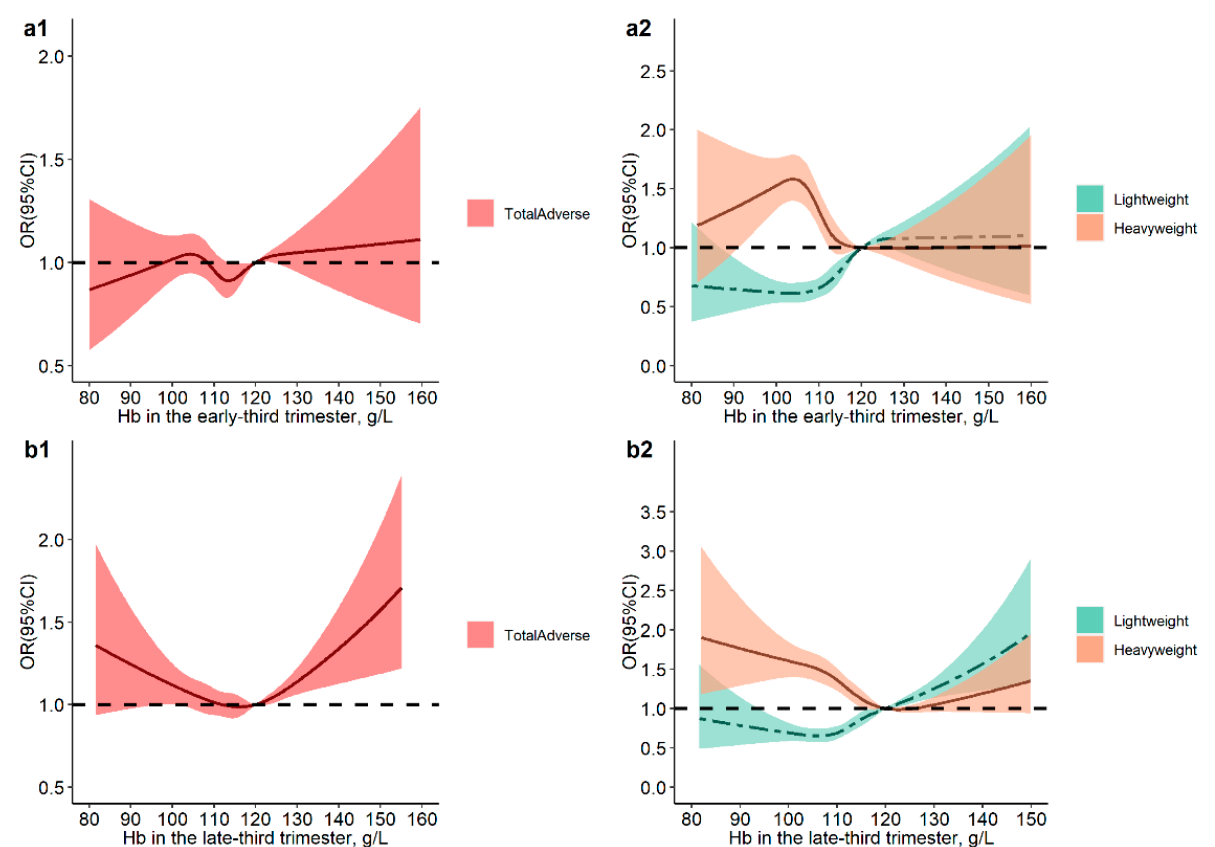
Figure 3. Dose–response associations of maternal hemoglobin in the early-third trimester ( a ) and in the late-third trimester ( b ) with neonatal complex outcomes (including SGA/LBW, LGA/macrosomia and total birth weight adverse outcomes). The p -values for overall associations were <0.001. The p -values for non-linear associations between Hb and total adverse outcomes were 0.064 ( a1 ) and 0.002 ( b1 ). The p -values for non-linear associations between Hb and SGA/LBW were 0.003 ( a2 ) and 0.028 ( b2 ), while the p -values for non-linear associations between Hb and LGA/macrosomia were <0.001 ( a2 ) and <0.001 ( b2 ). The models were adjusted for maternal age, education, parity, gestational age of hemoglobin measurement, neonatal gender, gestational age at delivery, mode of delivery, maternal BMI in the first trimester and weight gain during pregnancy. Hemoglobin at 120 g/L was set as the reference level.